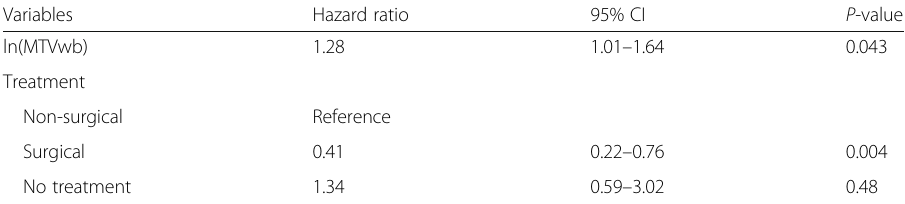
Table 3 Multivariate Cox regression analyses of whole cohort Variables